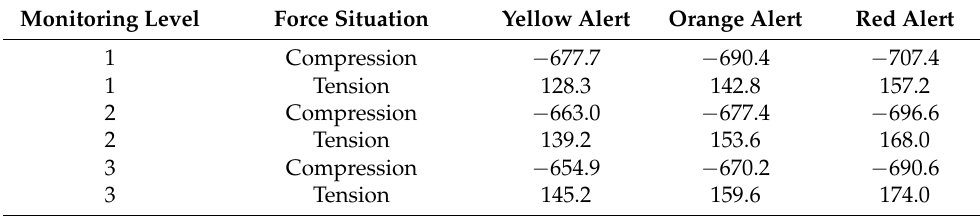
Figure 11. Schematic diagram of FBG monitoring system for shaft lining structure.